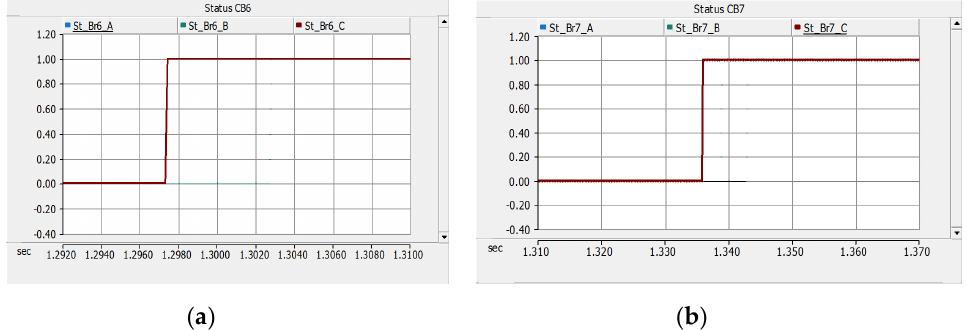
Figure 19. The operating times and status of breakers before, during and after the clearance of fault F2 in the islanded mode: ( a ) CB6 (main protection trip) and ( b ) CB7 (direct transfer trip).